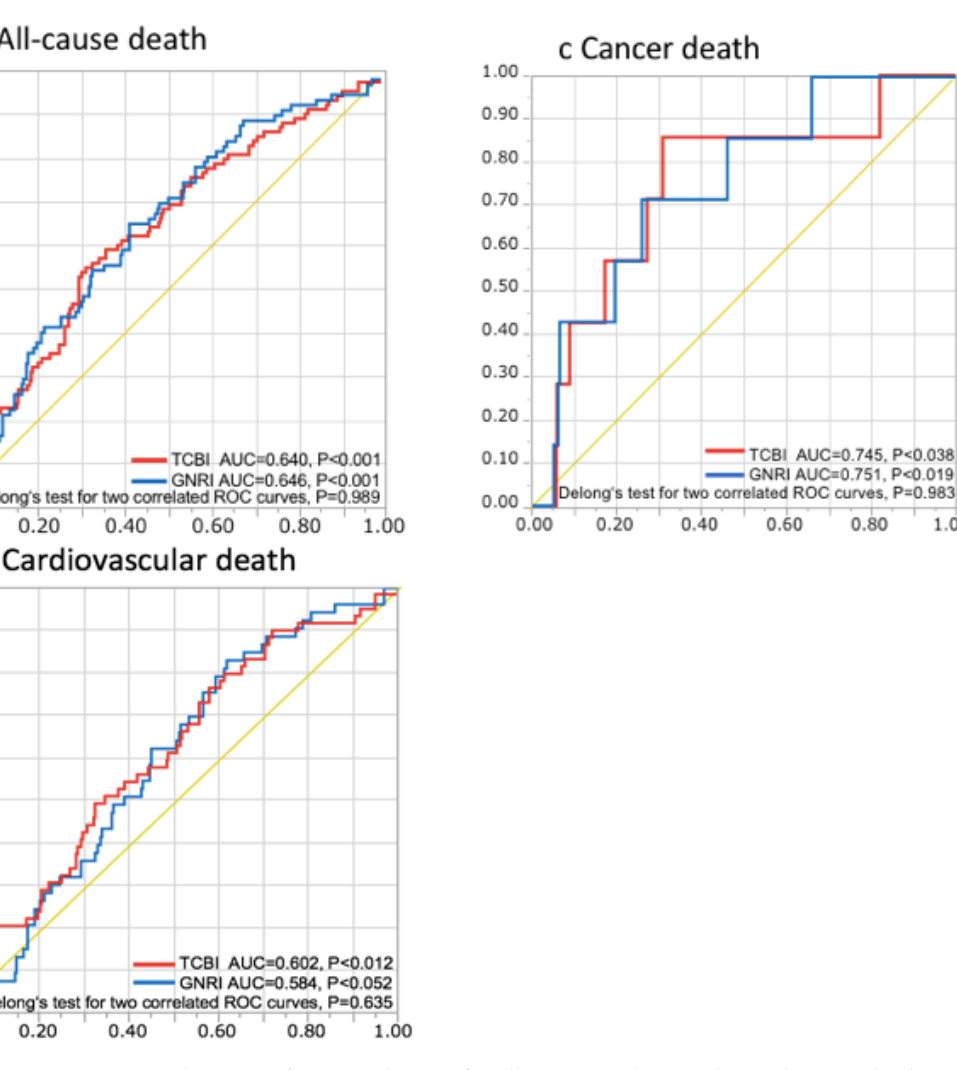
Figure 3. Prognostic implications of TCBI and GNRI for all-cause, cardiovascular, and cancer deaths. Receiver operating characteristic (ROC) curves of TCBI and GNRI with reference line for all-cause ( a ), cardiovascular ( b ), and cancer deaths ( c ). AUC: area under the curve